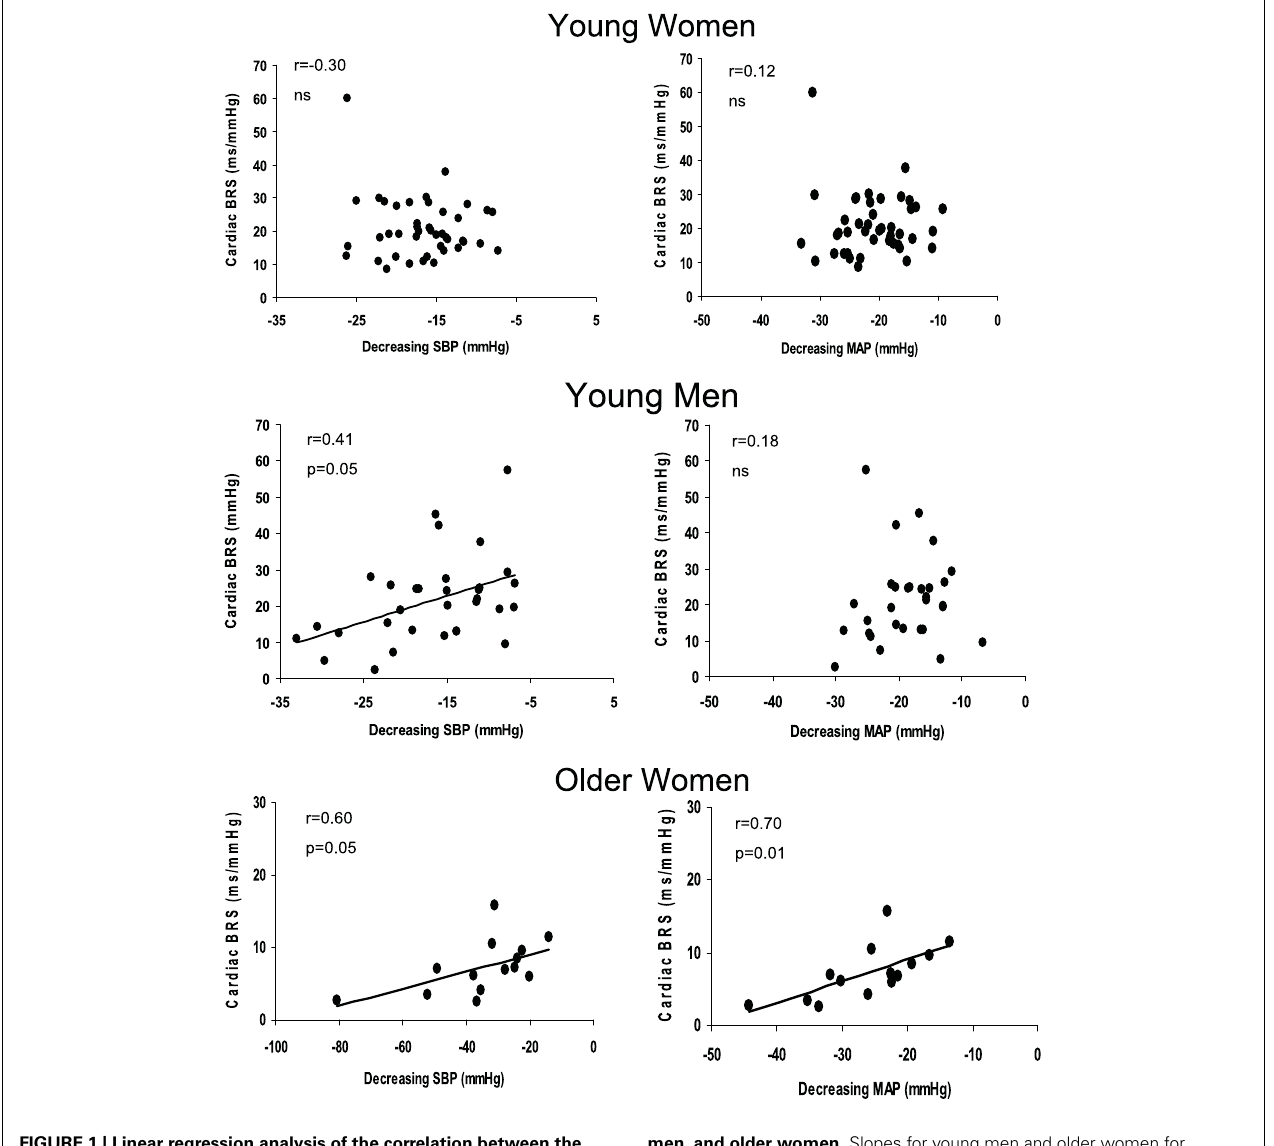
FIGURE 1 | Linear regression analysis of the correlation between the magnitude of decrease in SBP and cardiac BRS (left panel) and the magnitude of decrease in MAP during the decreasing pressure transients and cardiac BRS (right panel) in young women, young